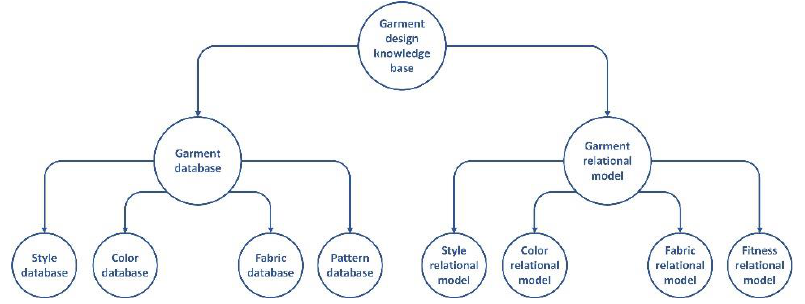
Figure 2. Hierarchical structure of the proposed garment design knowledge base.